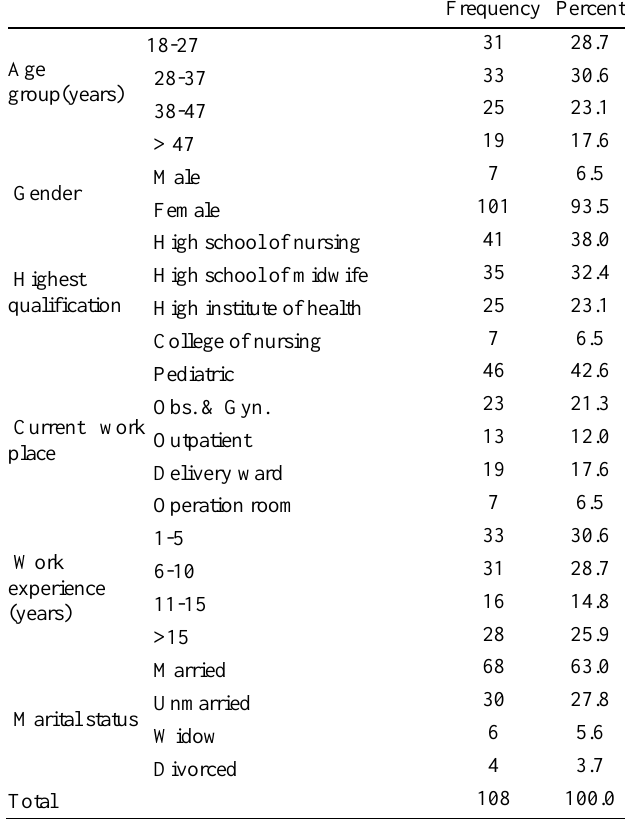
Table 1: Demographics Characteristics of the